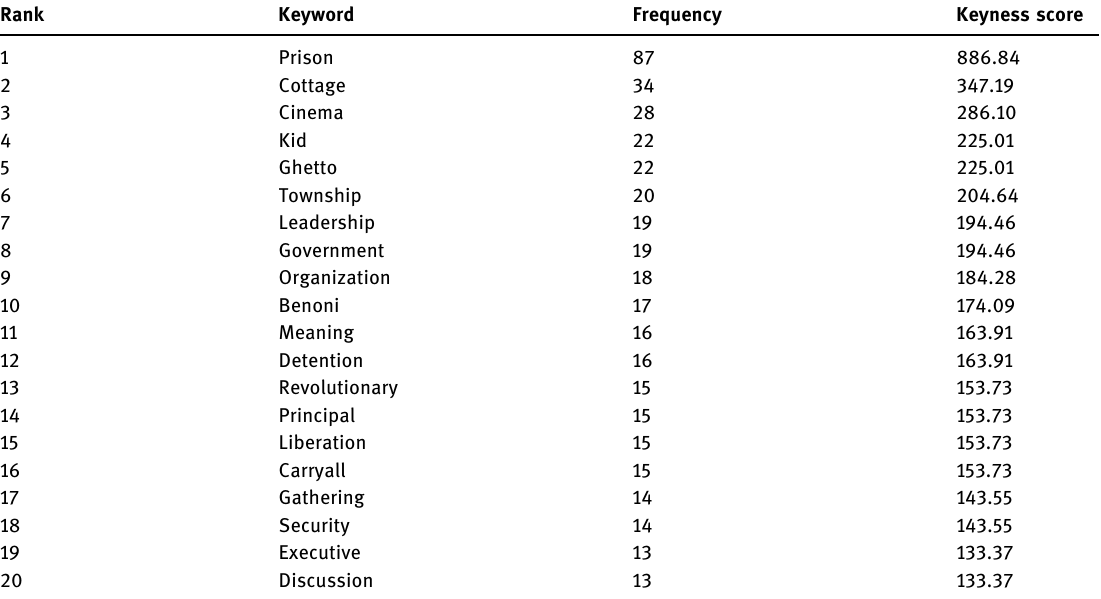
Table 1: Top 20 keywords in MSS ( characters ’ names excluded